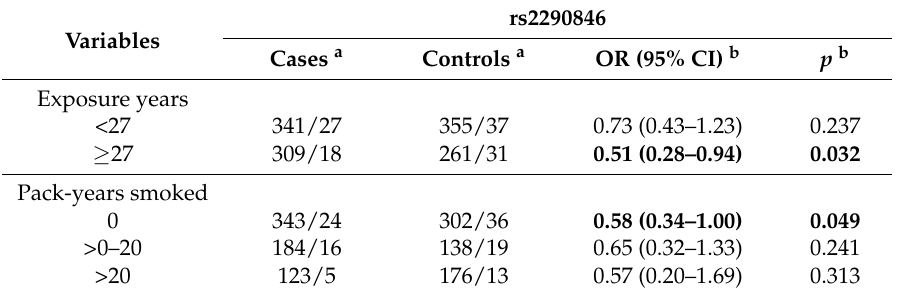
Table 4. Stratified analysis between the genotypes of LRBA rs2290846 and CWP risk.